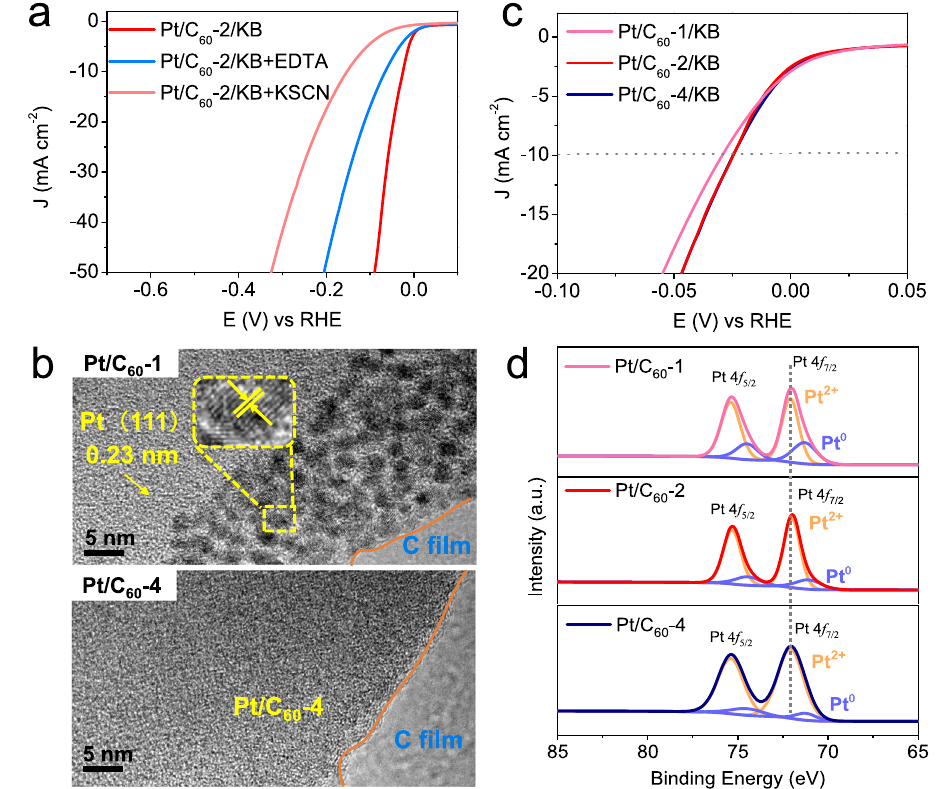
Fig. 6 | Control experiments for studying the active sites. a Catalyst poisoning experimentsforPt/C 60 -2/KBin1MKOHwiththeadditionof10mMEDTAorKSCN. b The HR-TEM images for the control samples Pt/C 60 -1 and Pt/C 60 -4. c